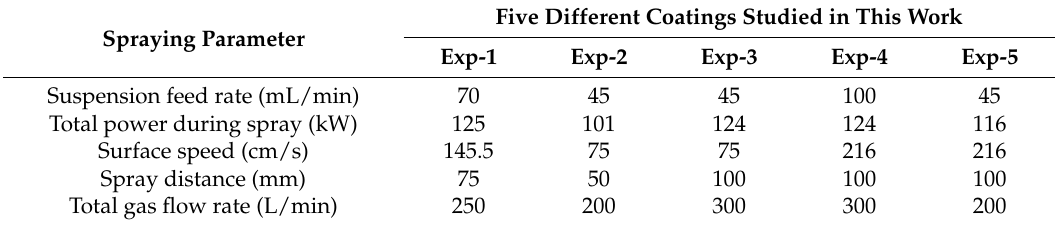
Table 1. Five different coatings studied in this work and spray parameters used to produce them [16]. Five Different Coatings Studied in This Work Spraying Parameter Exp-1 Exp-2 Suspension feed rate (mL/min)